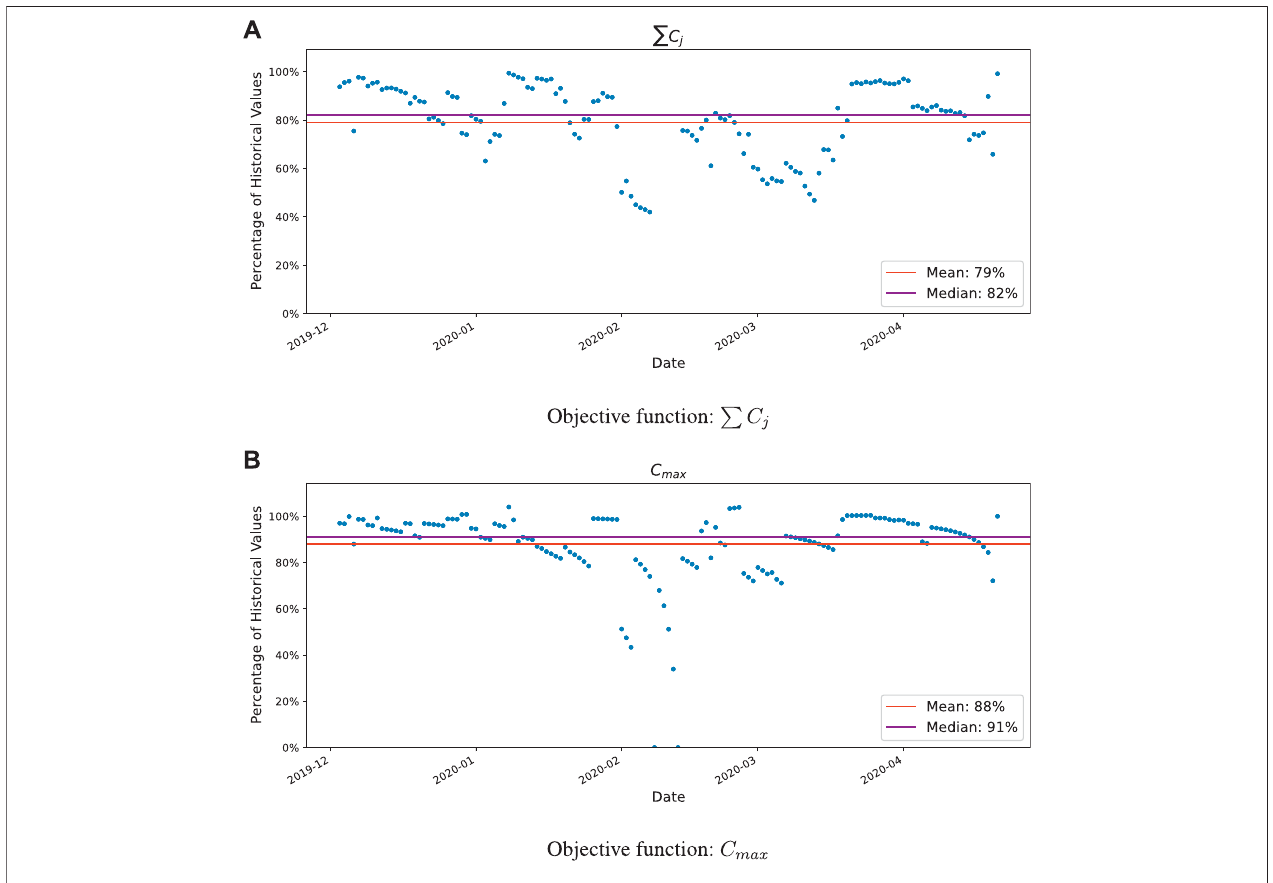
FIGURE 5 | 14-days percentage of historical values of model 1 (optimal FCFS model). (A) Objective function: (cid:1) C j , (B) Objective function: C max .